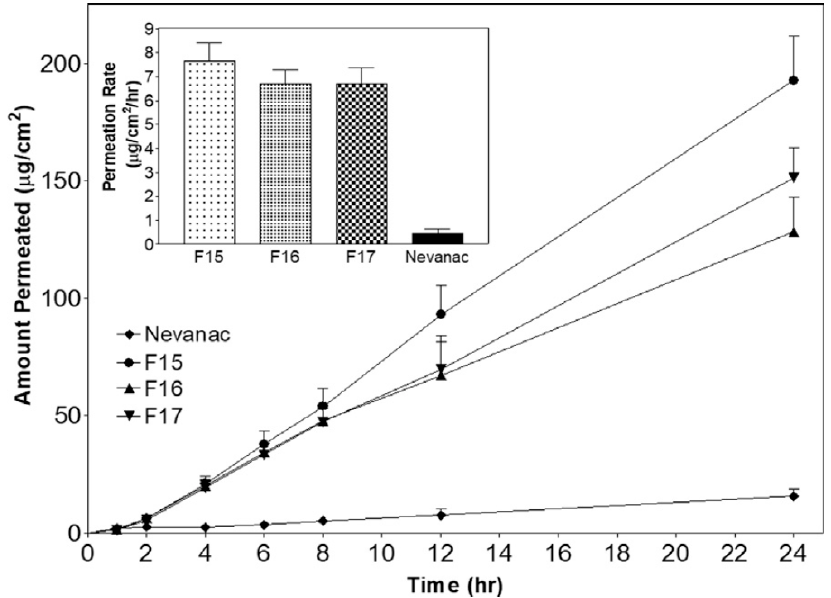
Figure 8. Ex vivo permeation test of nepafenac-HPBCD containing an in situ gelling system on porcine cornea. Nevanac: Official product used as reference, F15: 0.1 w/v % sodium-alginate, F16: 0.3 w/v % sodium-alginate, F17: 0.5 w/v % sodium-alginate [47].